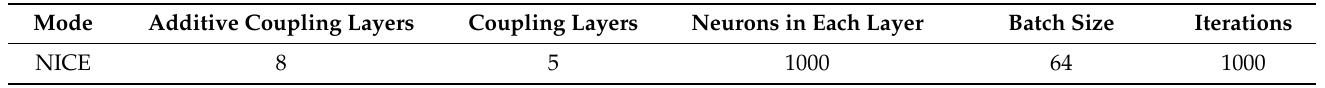
Table 2. NICE model parameters.